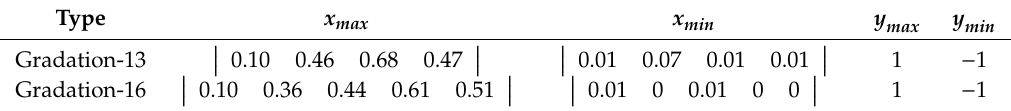
Table 10. The gradation normalization parameters for Gradation-13 and Gradation-16. Type x max x min